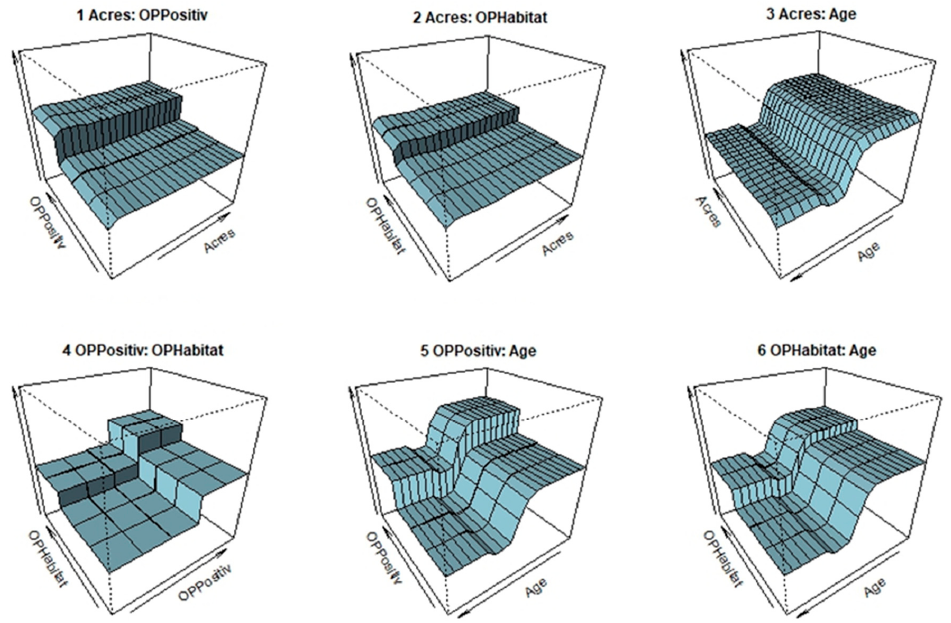
Figure 7. Interactions of the variables for the willingness to produce/harvest mode. (OPPositiv: Landowners’ positive opinion on the idea of creating energy from trees growing in their property. OPHabitat: Landowners’ opinion that bioenergy crops can provide more habitat).